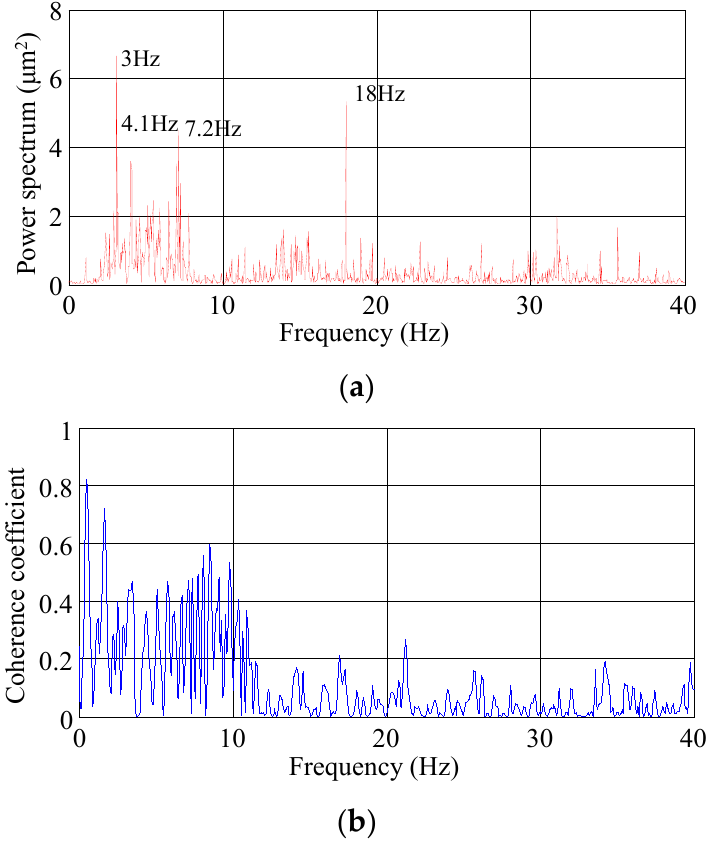
Figure 10. MP-FRF ( a ) and coherence coefficient ( b ) between the main source at orifice and T9. Therefore, compared with the superimposed multiple sources as input, the accuracy of the predicted frequency is improved when the main source is used as the input. Further, when the input or output has two or more frequency bands with relative high energies, the prediction results are more easily affected by factors such as noise that make the prediction amplitude too large. Therefore, the input and output signals need to be preprocessed before using MP-FRF.